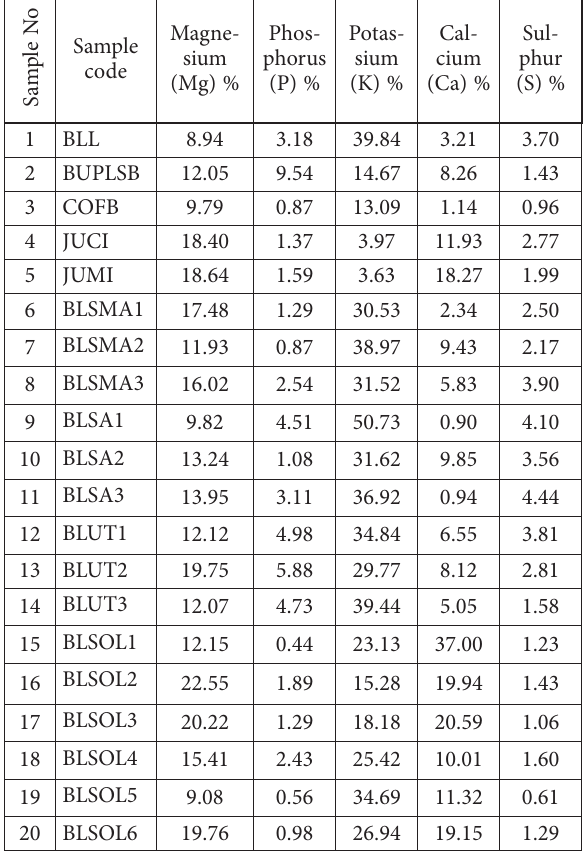
Table 2. Concentrations of macro-nutrients (% by weight) in ash samples of plant